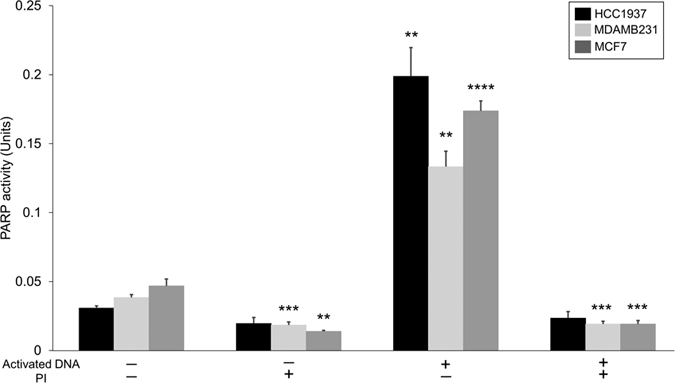
Effect of PARP inhibition on basal activity (-activated DNA) and on activation (+activated DNA) in breast cancer cells.PARP activity increased more than 6-fold in HCC1937 cells and 3.5-fold in MCF7 and MDAMB231 cells in the presence of activated DNA relative to respective basal activities. PARP was inhibited using 50 μM ABT-888 which led to about 80% reduction in PARP activity compared to the DMSO control in the three cell lines. Statistical analysis is performed on samples from three biological replicates using two-tailed t-test for comparing the PARP activity in each cell line relative to their basal levels (−/−). The error bars represent standard deviations. *p < 0.05, **p < 0.01, ***p < 0.001, ****p < 0.0001 relative to respective basal levels (−/−).